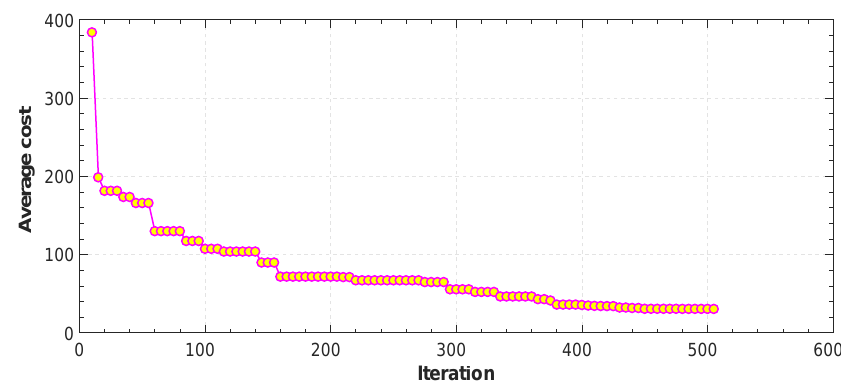
Figure 17. Average cost function vs. iteration for